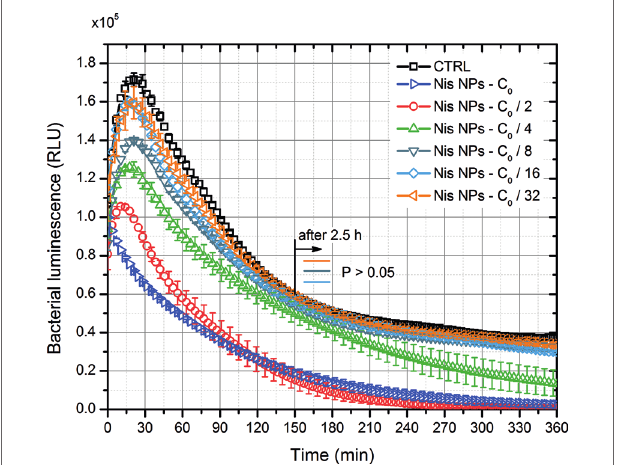
FIGURE 3 | The dependence of bacteria luminescence on the concentration of nisin nanoparticles (Nis NPs). CTRL—control without nisin nanoparticles. C 0 corresponds to highest concentration of 0.2 mg/ml.